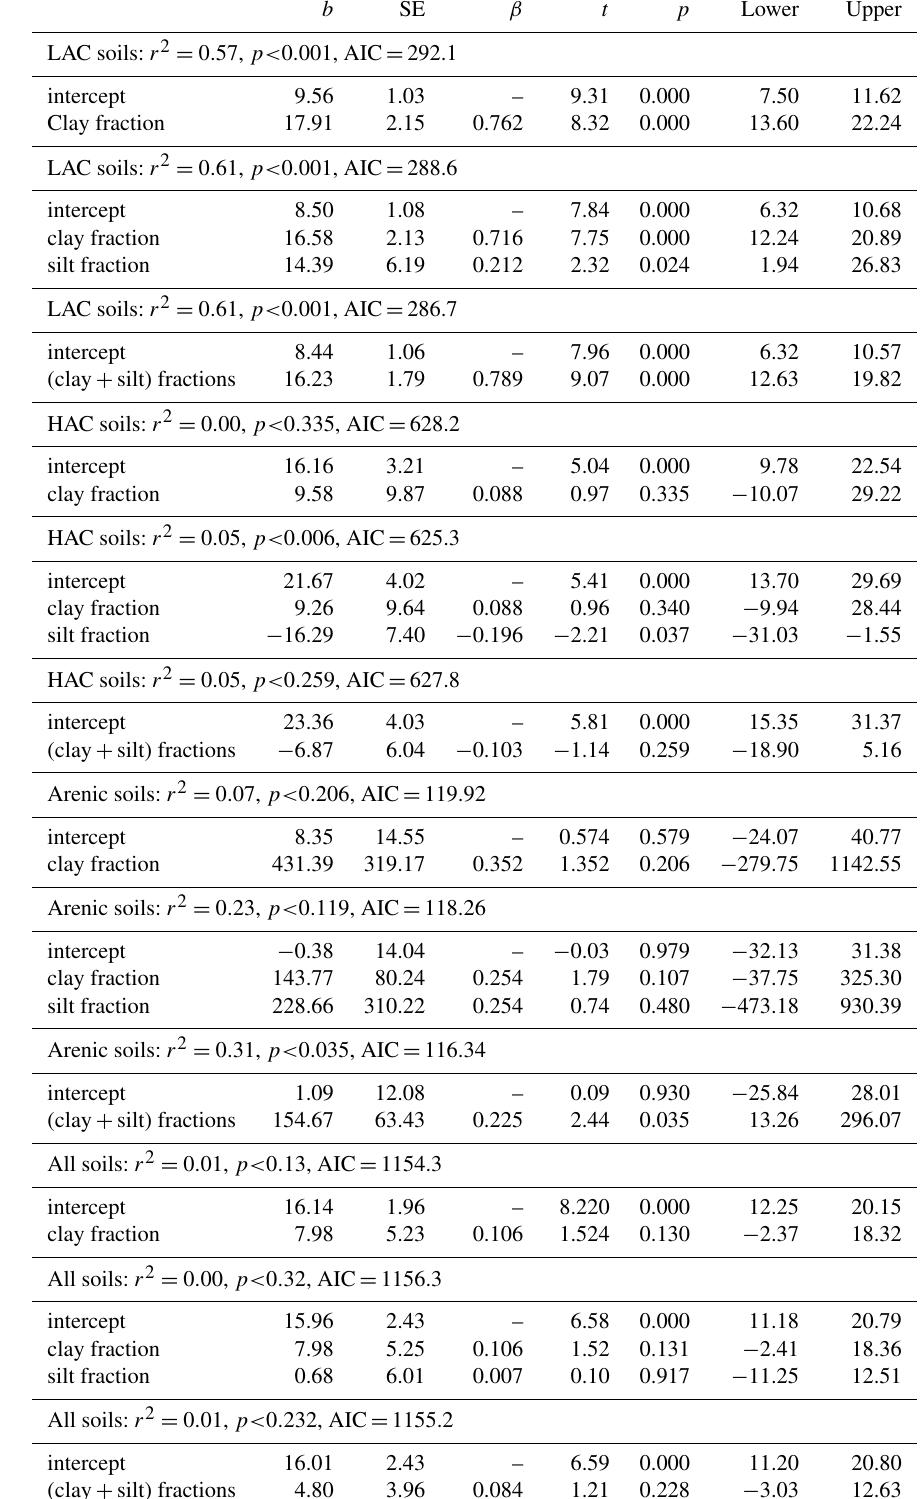
Table 4. Summary of OLS regression coefficients for soil organic carbon and texture associations. b SE β t p Lower Upper LAC soils: r 2 = 0 . 57, p< 0 . 001, AIC =